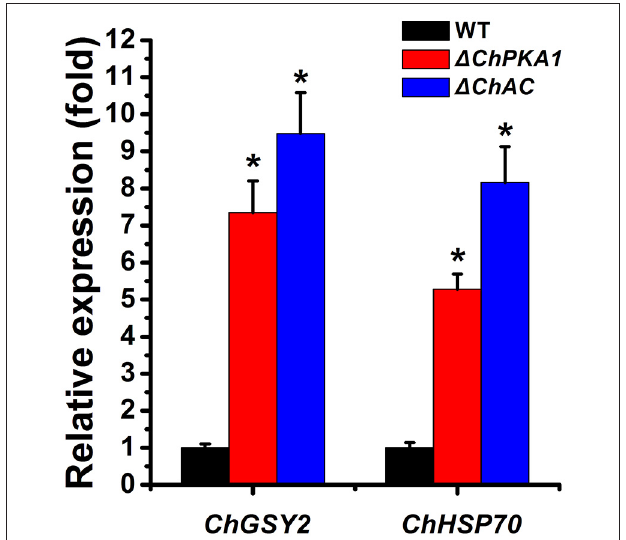
FIGURE 8 | The relative expression of ChGSY2 and ChHSP70 in the hyphae of wild type strain CH-1, mutants ∆ ChPKA1 and ∆ ChAC incubated at 35 ◦ C for 3h. The relative expression of target genes in CH-1 was set as level 1. Expression level of C. higginsianum β -tubulin ( CH063_04743 ) gene was used to normalize different samples. Bars represent standard deviations from three replications. Asterisks indicate statistical differences from ∆ ChPKA1 and ∆ ChAC , P ≤ 0.01.